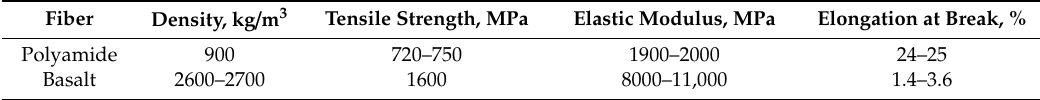
Table 4. Technical characteristics of the micro-reinforcing